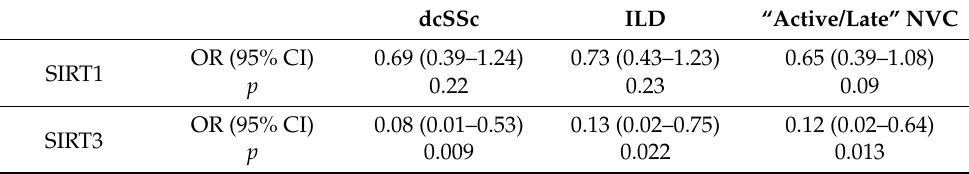
Table 2. Logistic regression analysis model combining serum SIRT1 and SIRT3 levels. dcSSc ILD “Active/Late”